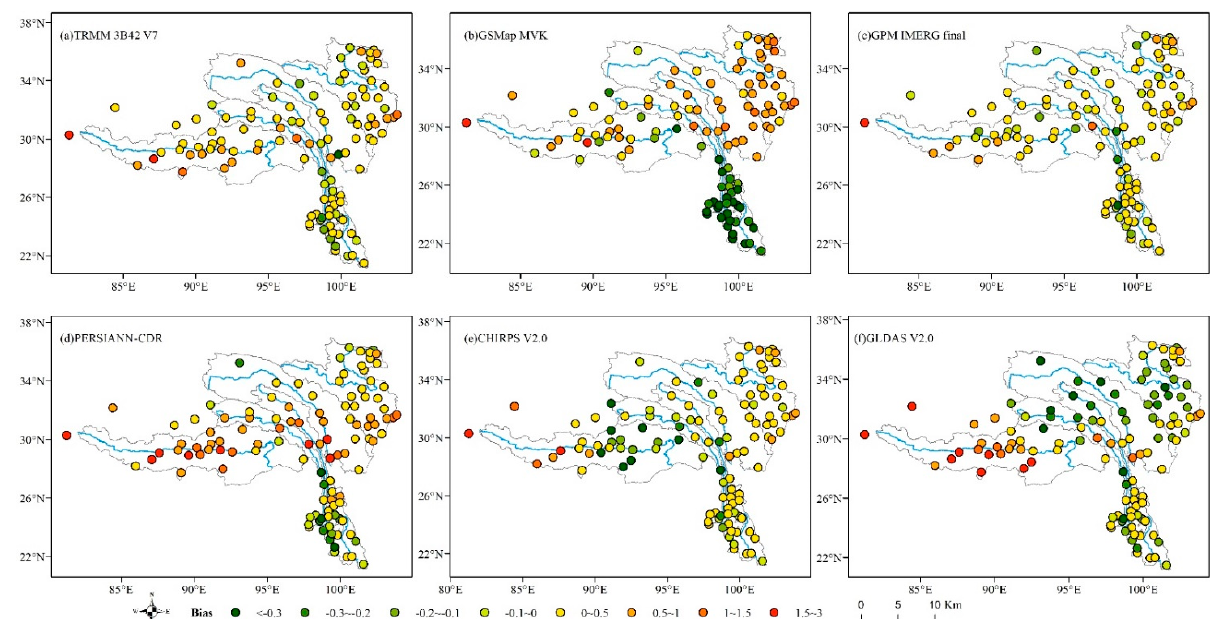
Figure 6. The degree of deviation between different rain gauges and corresponding grids in data products.